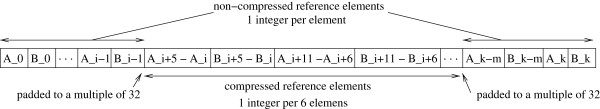
Compressed inter-reference memory organization. The non-compressed fractions of the vector are processed by the square blocks while the compressed part is processed by the rectangular blocks.